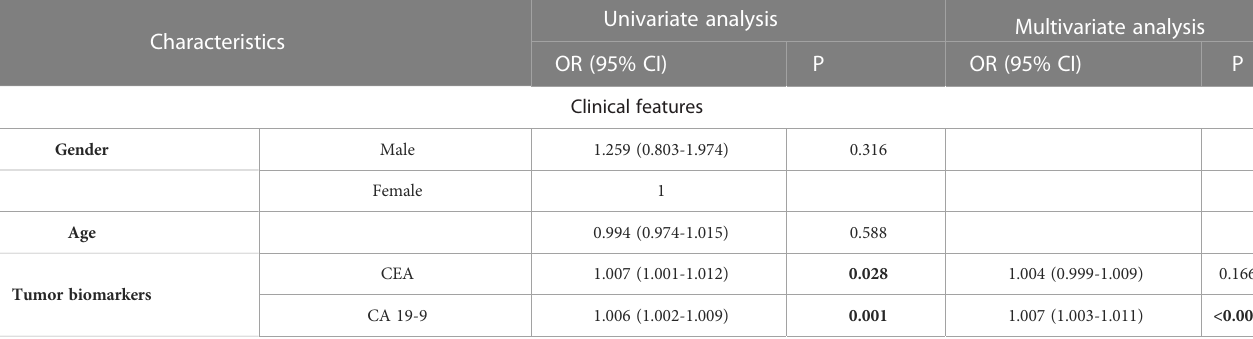
TABLE 2 Uni- and multi-variate analysis of clinical and radiological